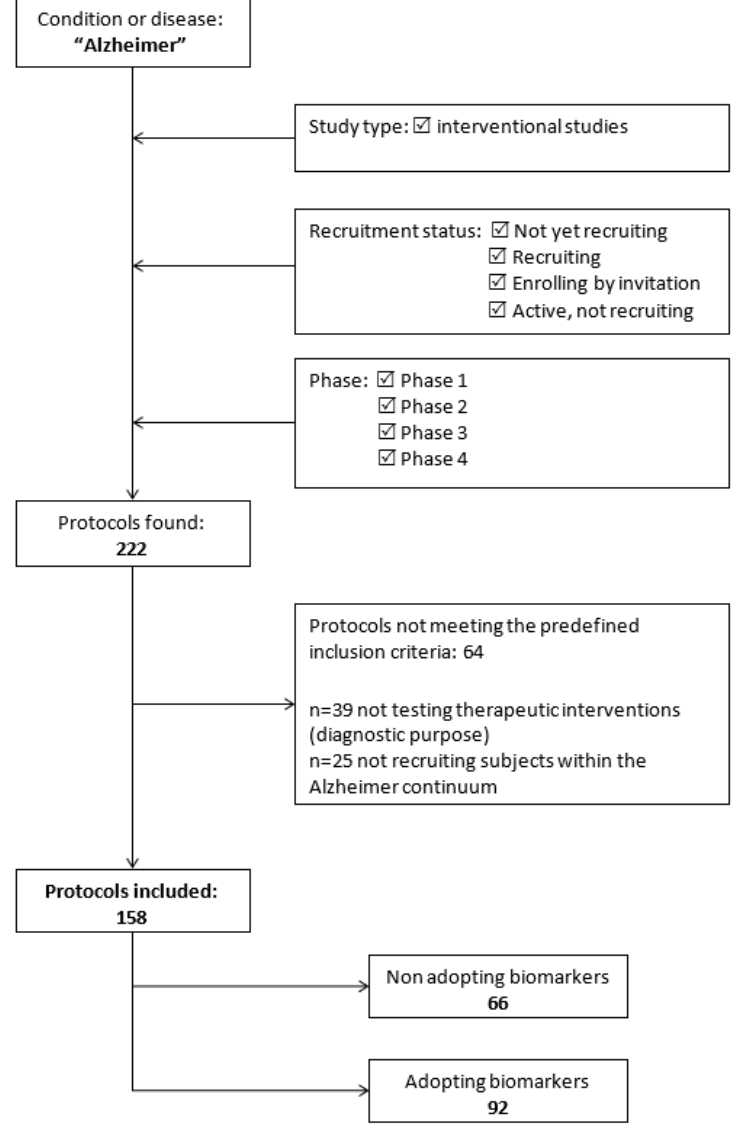
Figure 1. Flow-chart of protocols’ selection.